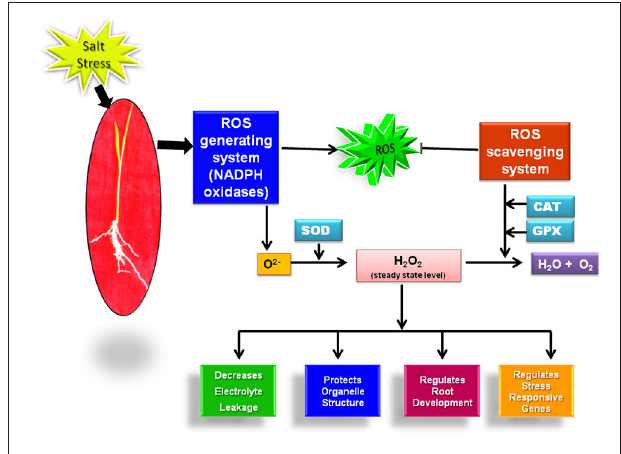
FIGURE 1 | Reactive oxygen species (ROS) mediated regulation of salt stress tolerance in